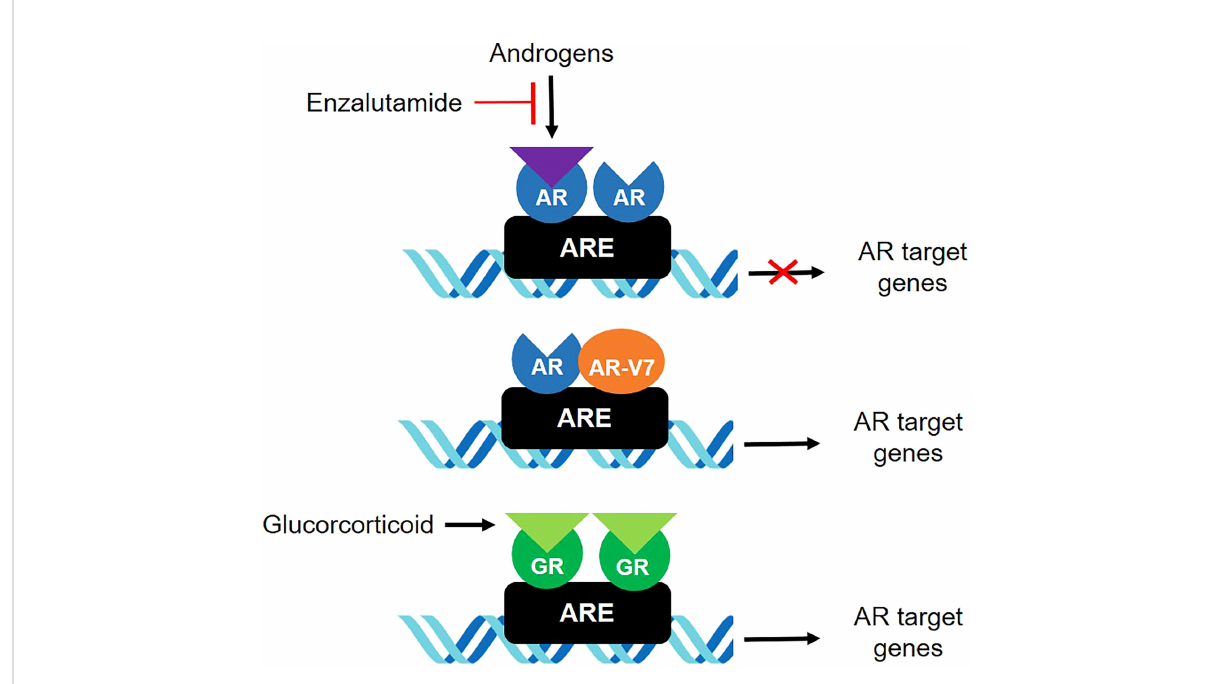
FIGURE 4 GR and AR-V7 in androgen-independent mechanisms involved in resistance of CRPC to